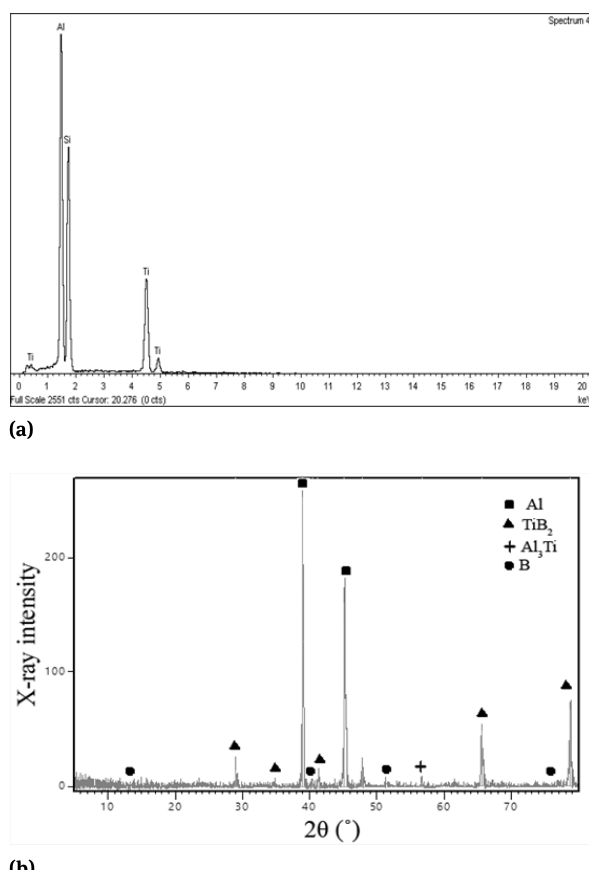
Figure 4: (a) XRD graph for Temperature 750 ∘ C and 6% SiC MMC; (b) XRD graph for Temperature 820 ∘ C and 6% TiB2